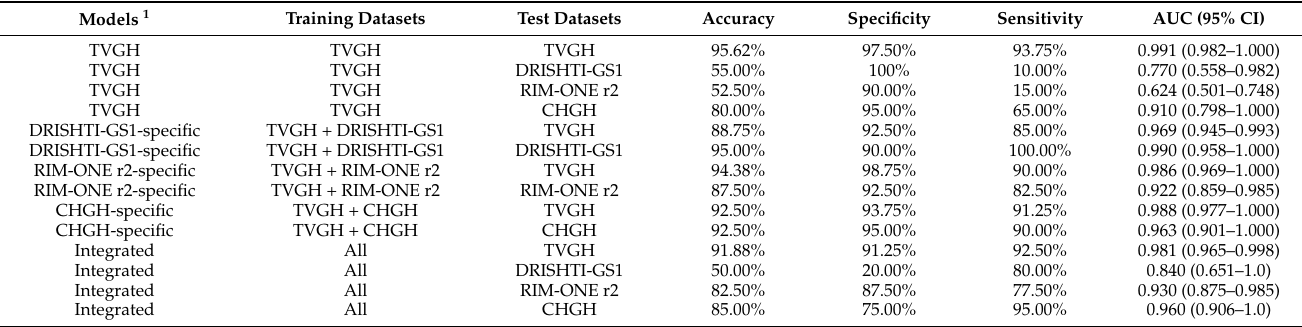
Table 3. Diagnostic performance of the deep learning models built with different training datasets on test images across different